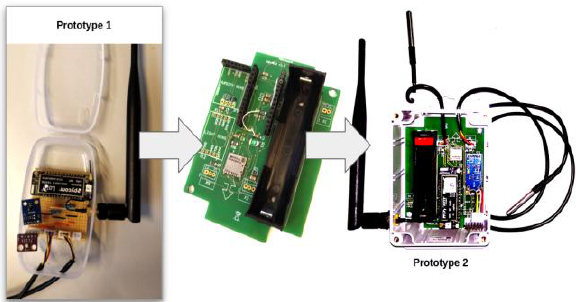
Figure 3. The prototype development.